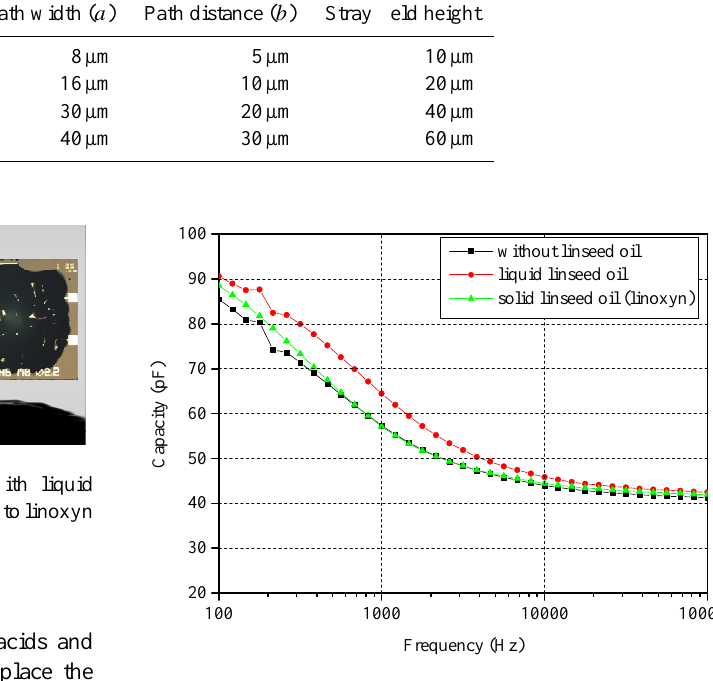
Figure 6. Capacity of a structure with a diameter ( d ) of 3mm ( a = 40µm, b = 30µm) in a frequency range of 100Hz to 100kHz, at conditions with and without solid and liquid linseed